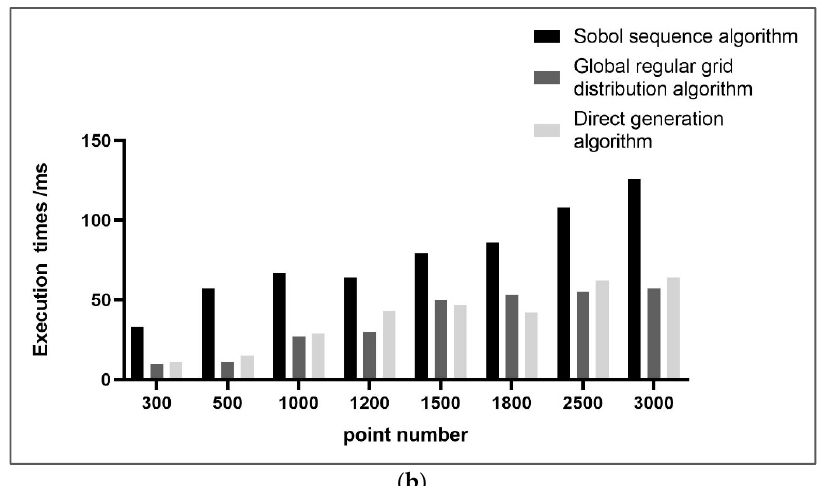
Figure 5. Schematic diagrams of three algorithms’ e ffi ciency comparison results. The two groups’ experiments are both generate points in two-dimensional space C 2 = [ 0,1 ] 2 . In ( a ), the three algorithms are respectively generate 2500 points in space C 2 , while in ( b ), the three algorithms are respectively generate eight groups’ di ff erent numbers of points in space C 2 .